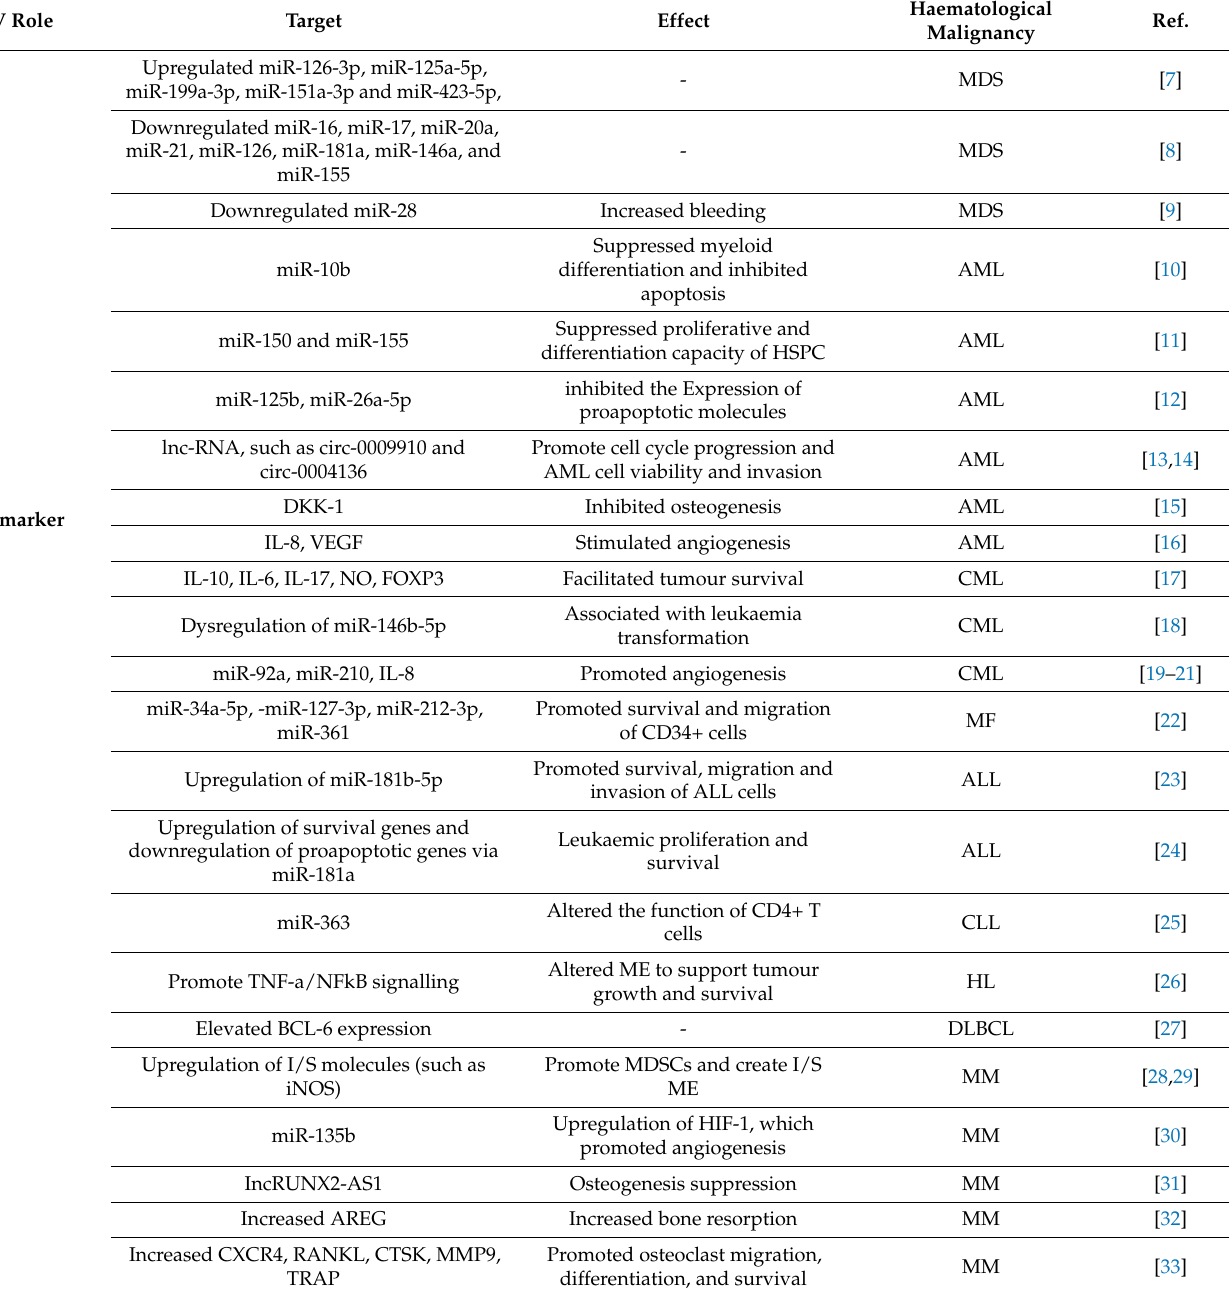
Table 1. Overview of diagnostic, prognostic and therapeutic potential of EVs in the context of haematological malignancies. The table illustrates the contribution of EVs to haematological malig- nancies and more specifically in their role as a biomarker, in disease outcomes, in drug resistance and as a therapeutic target. Furthermore, the associated EV cargo and resulting effect are